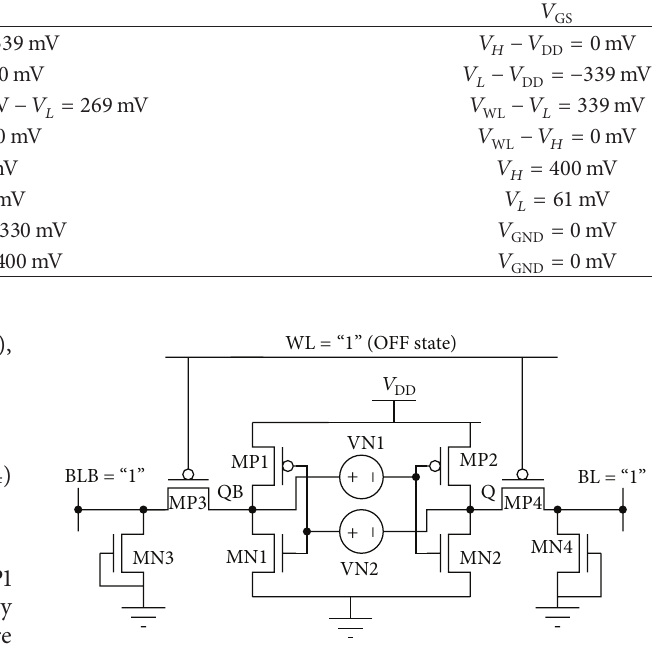
Figure 6: Test circuit for measurement of hold SNM of MPT8T.